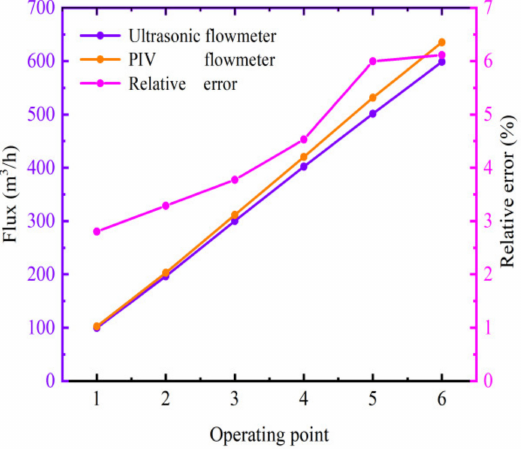
Figure 7. Measurement